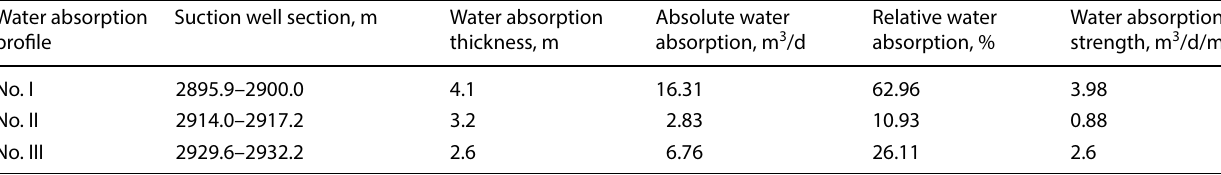
Table 2 Horizon distribution of water absorption profile Water absorption